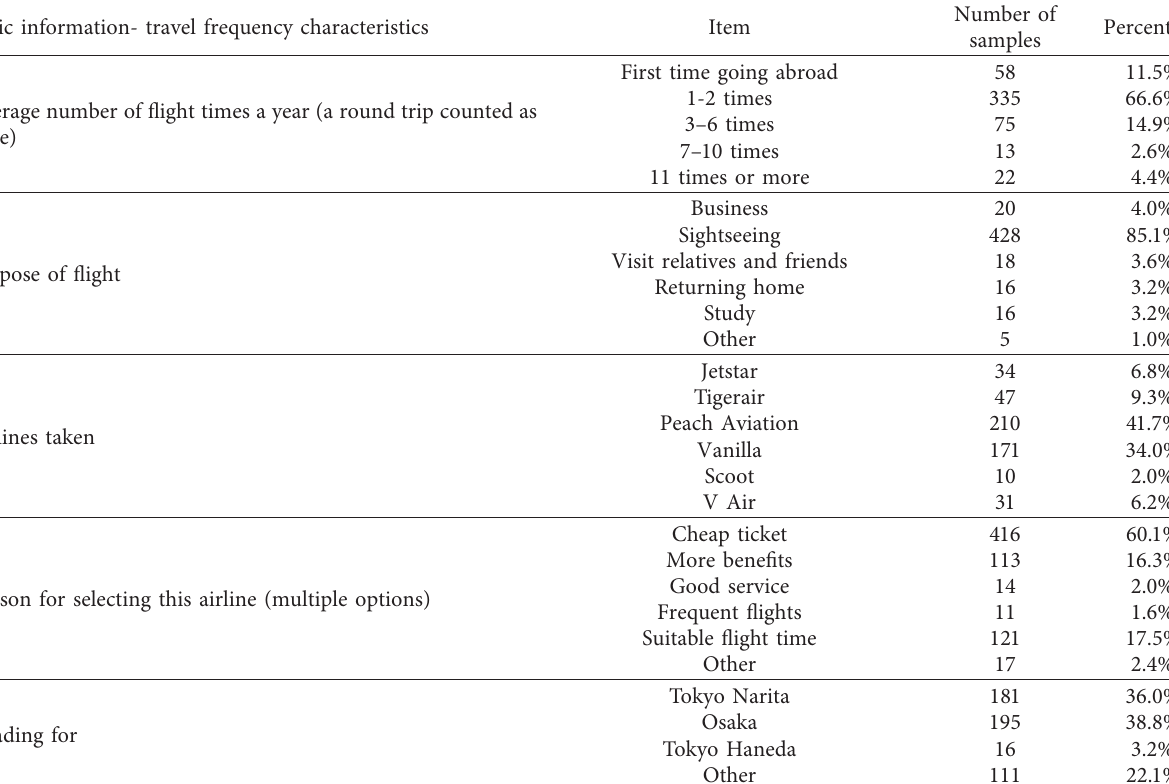
Table 2: Travel frequency characteristics data analysis.